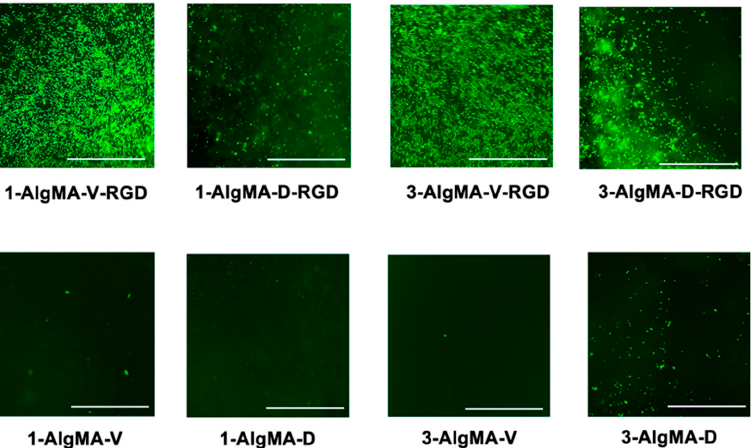
Figure 6. Qualitative fluorescent images of Calcein-AM stained C2C12 cells (bright green) indicated that the scaffolding materials supported cell adhesion and maintained cell viability after 24 h of culture in vitro. The visible-light crosslinked samples indicated higher cell densities compared to the dual-crosslinked samples within the 1 and 3% ( w / v ) AlgMA-v-RGD groups (scale bar = 1 mm).